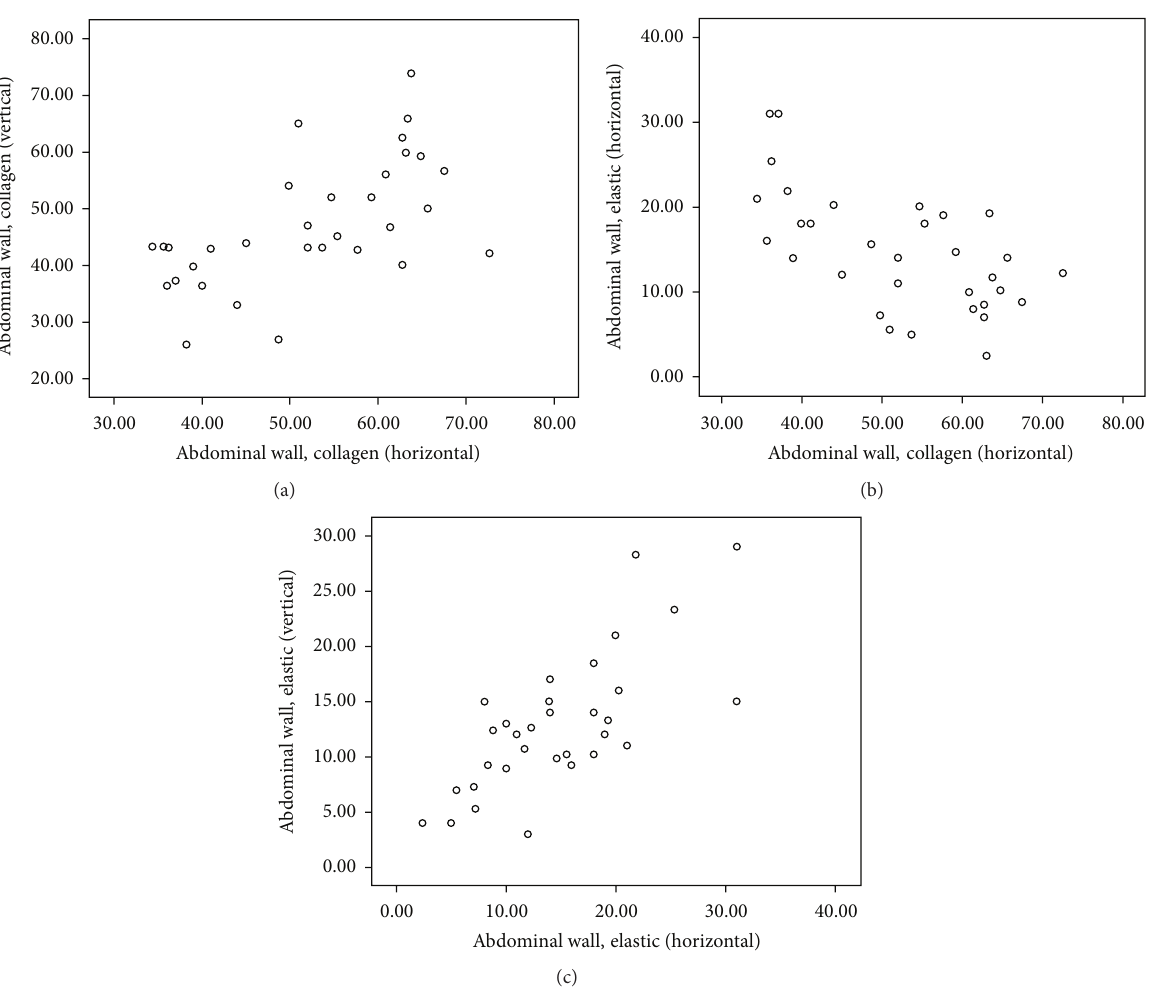
Figure 4: Scatter plot of significant Spearman correlation pattern at anterior abdominal wall. (a) Moderate positive correlation between C H and C V . (b) Moderate negative correlation between C H and E H . (c) Moderate positive correlation between E H and E V (C H : collagen in horizontal, C V : collagen in vertical, E H : elastic in horizontal, and E V : elastic in vertical